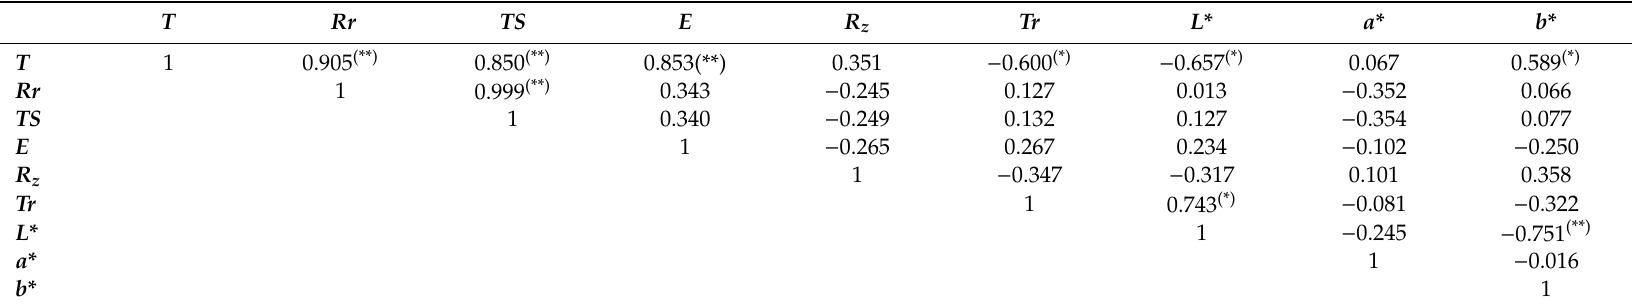
Figure 2. Applications of edible biofilms incorporated with Stevia rebaudiana (soluble coffee, dehydrated vegetables, cheese slices, meat slices, and medicine). Table 2. Pearson correlation matrix between physical and mechanical parameters. Table 2. Pearson correlation matrix between physical and mechanical